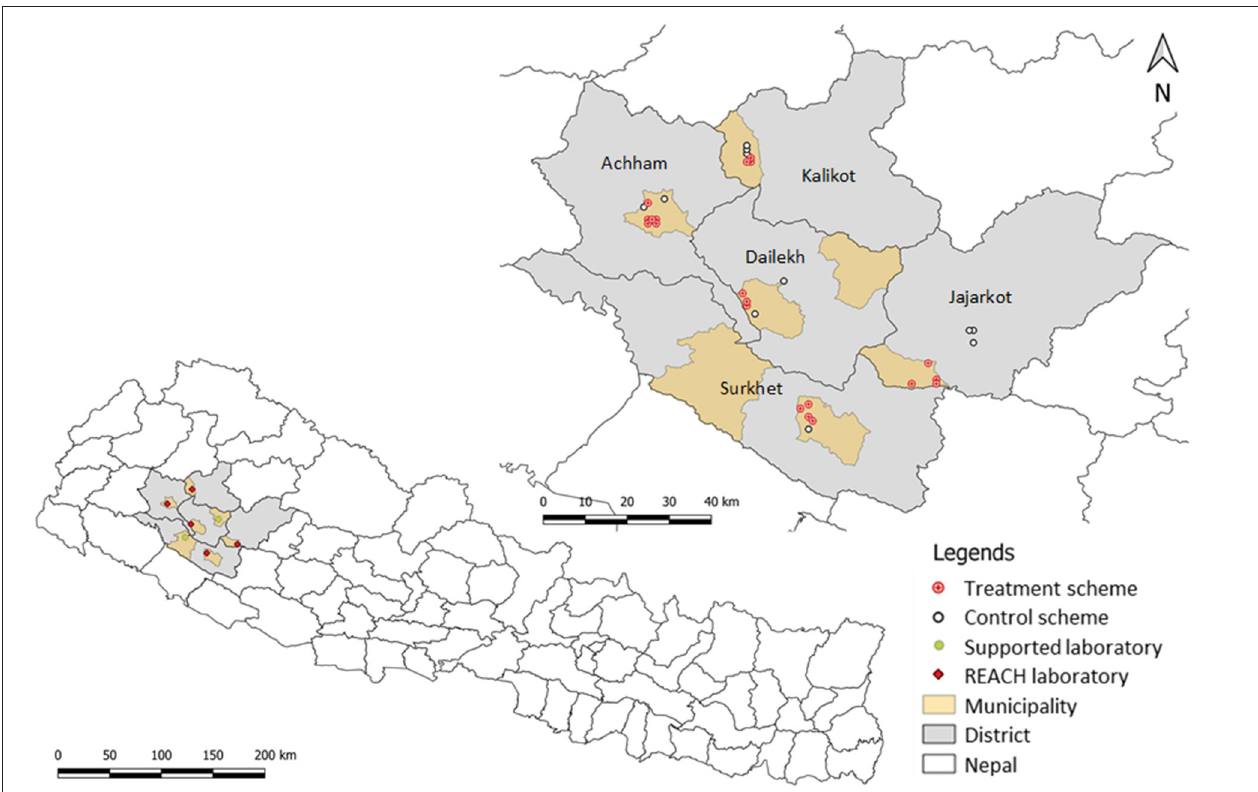
FIGURE 1 | Map of Nepal with the five districts involved in the Integrated Water Resource Management (IWRM) Programme, showing the locations of the treatment and control drinking water systems (DWS) and the laboratories implemented for this study (REACH laboratories).